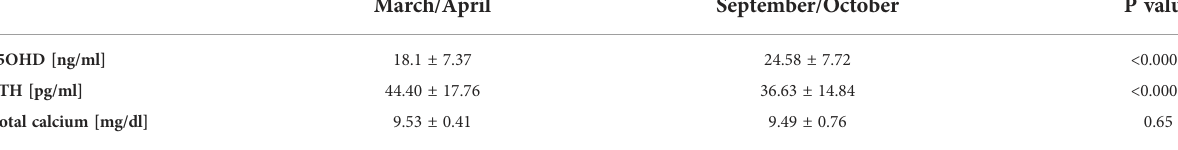
TABLE 2 Concentrations of 25OHD, parathormone (PTH) and total Calcium (mean ± SD) in 125 healthy subjects not taking any 25OHD supplements tested twice in spring and in autumn from a single urban general practice in the city of Lodz, Poland, latitude 51°75 ’ N.